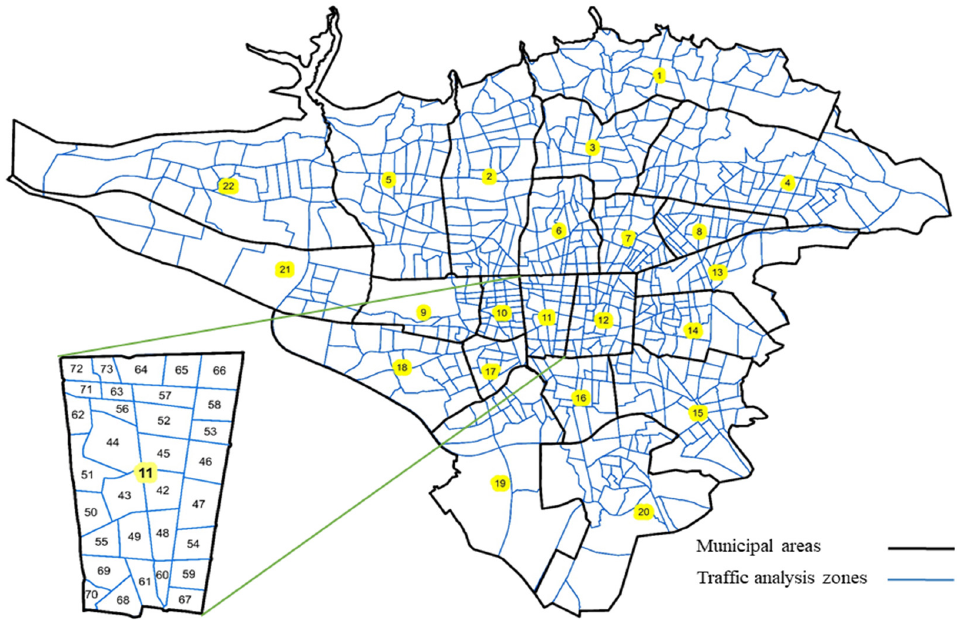
Figure 1. Tehran zoning map.